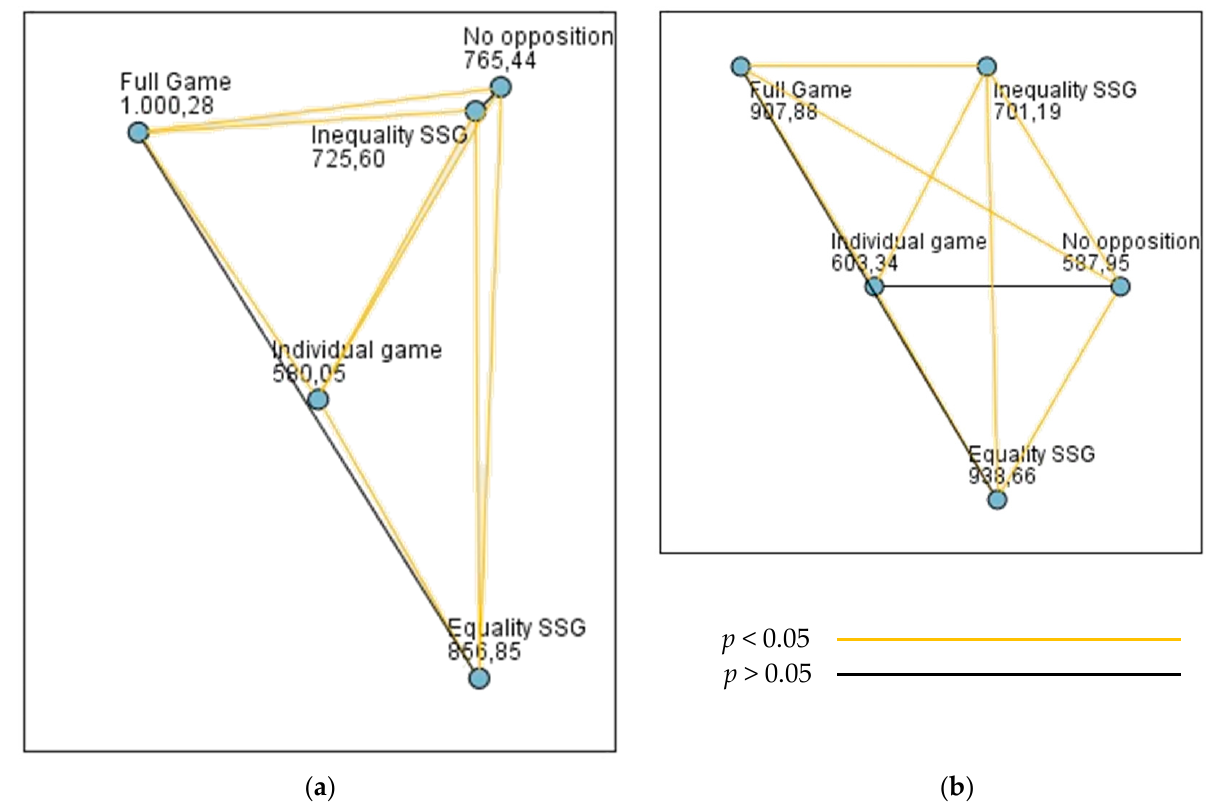
Figure 6. Multiple pairwise comparisons of the PL/min and HR avg variables according to the game situation. Note: eTL = external load; PL = Player Load; min = minute; iTL = internal load; HR = Heart Rate; SSG = Small-Sided Game. ( a ) eTL (PL/min) and ( b ) iTL (HR avg ). Table 5. Reference values according to the interaction of the independent